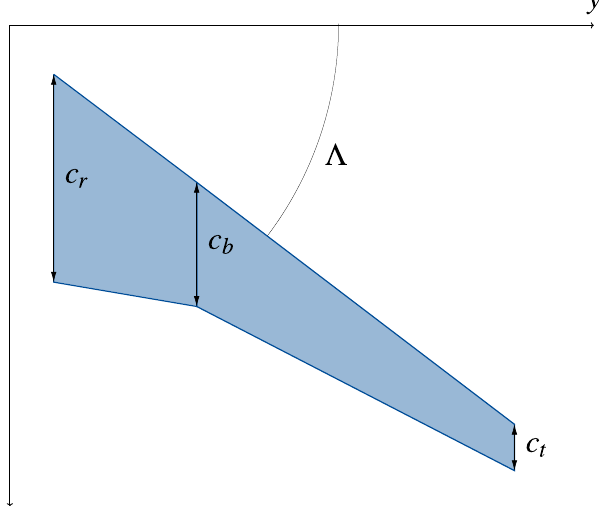
Fig. 3. Wing planform design variables: wing root, break, and tip chords ( c r , c b , and c t respectively) and sweep angle Λ